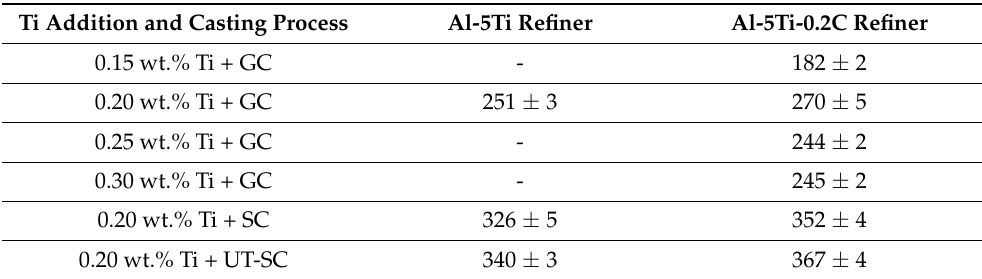
Table 3. The ultimate tensile strength (MPa) of alloy samples with different